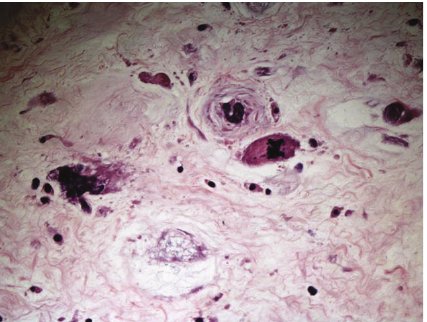
Figure 2: Computed tomography (CT) of the abdomen and the pelvis confirming the presence of a 22 × 19 × 8 cm retroperitoneal mass, extending anteriorly to abdominal wall of right upper quad- rant and winding the entire distal right kidney.